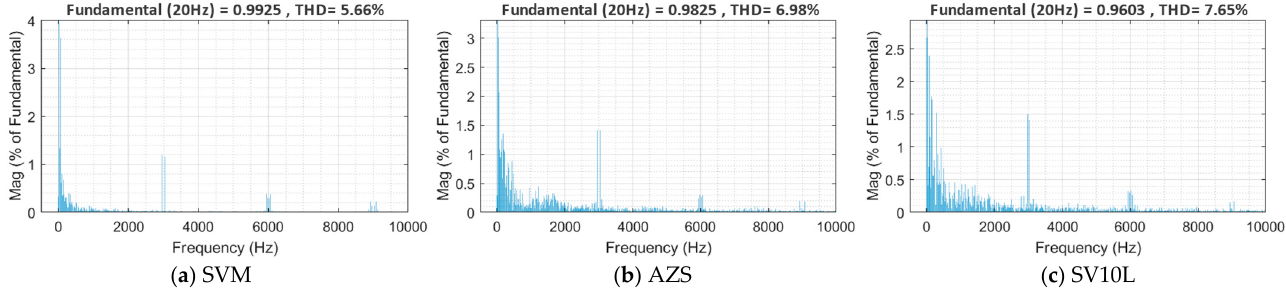
Figure 11. Fourier Transform analysis for the motor current for the analyzed PWM schemes.